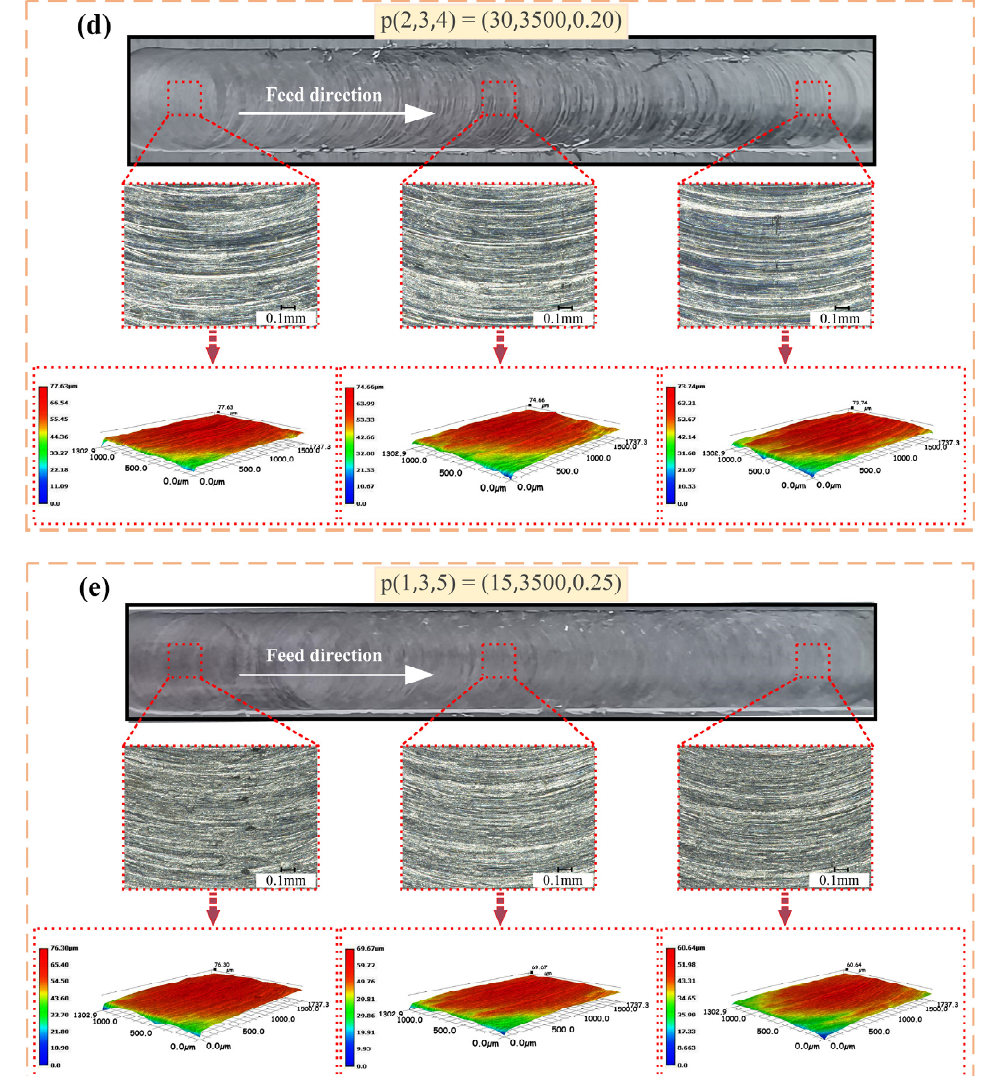
Figure 6. Photomicrographs of the machined surface morphology at different processing areas. ( a )